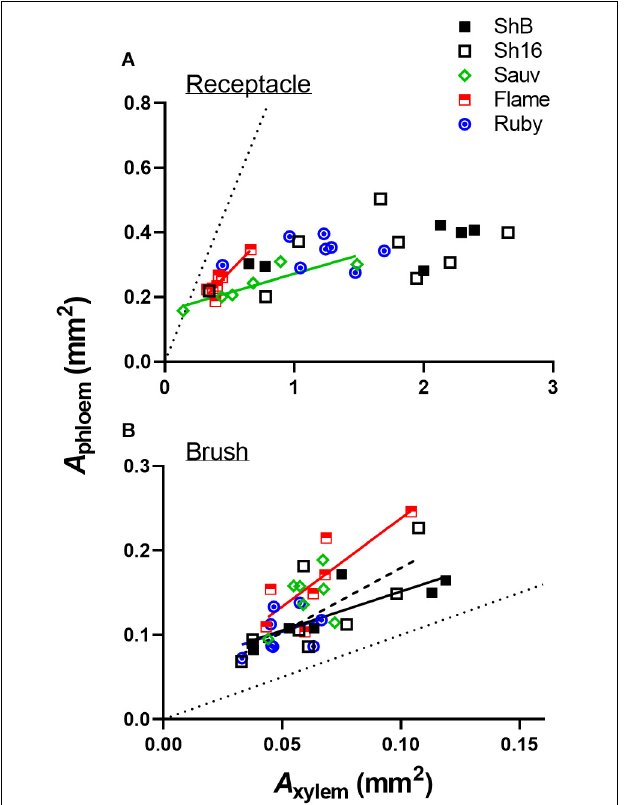
FIGURE 12 | Correlations between A phloem and A xylem in receptacle (A) and brush zone (B) for pre- and post-veraison Shiraz BVRC12 (ShB), Shiraz 1654 (Sh16), Sauvignon Blanc (Sauv), Flame Seedless (Flame), and Ruby Seedless (Ruby) in 2017/2018 season. Where linear lines are shown, this indicates a positive correlation (Pearson’s r , P < 0.05) between A phloem and A xylem in the respective cultivar. Dotted diagonal lines are y =